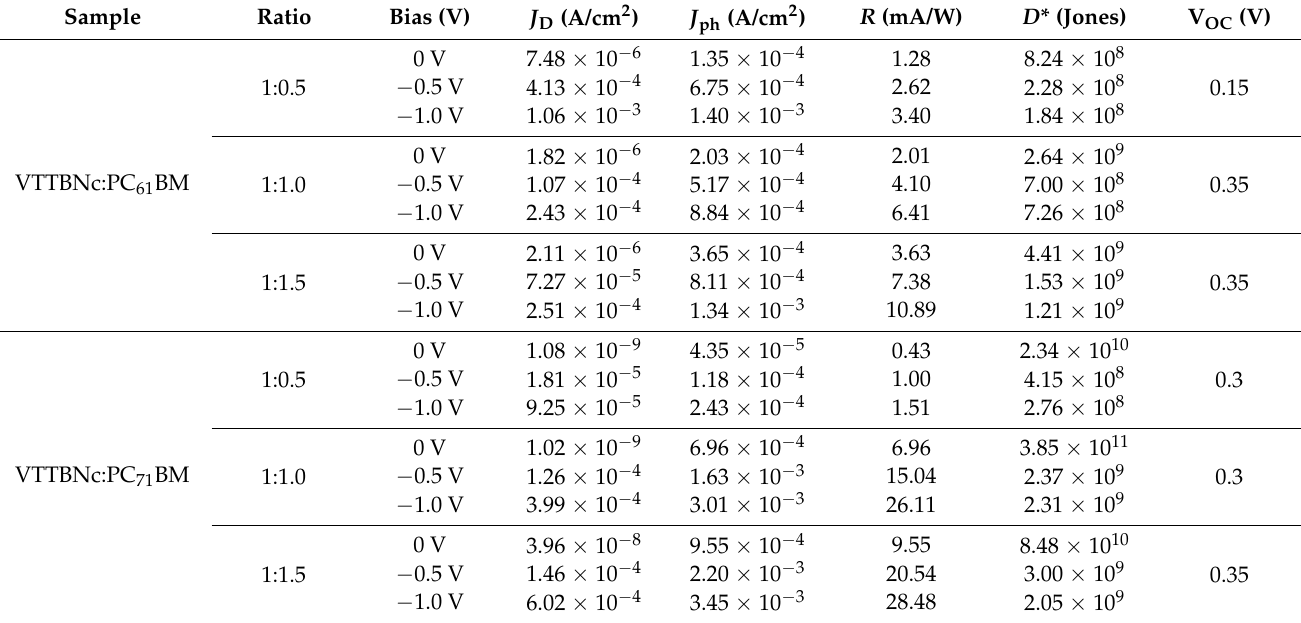
Table 2. Performance of VTTBNc:PC 61 BM and VTTBNc:PC 71 BM as a